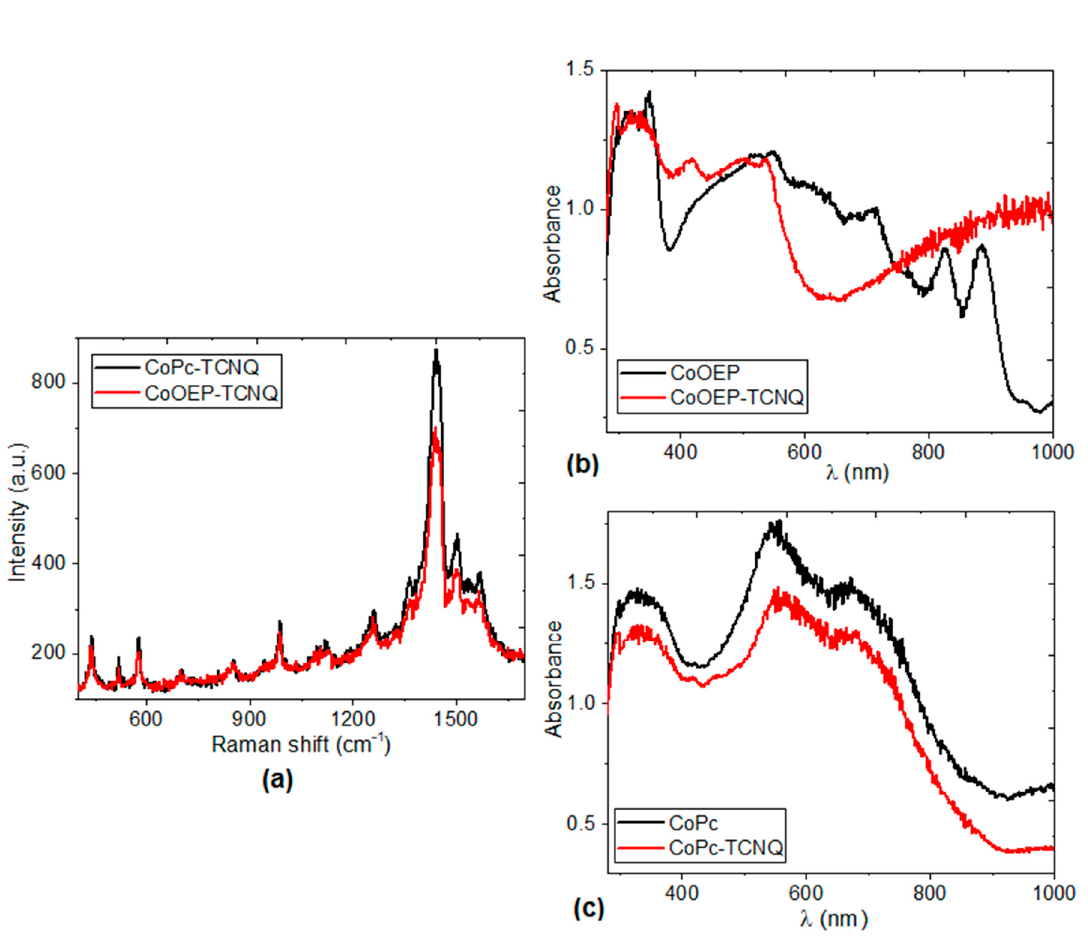
Figure 7. ( a ) Raman spectra of the CoPc-TCNQ and CoOEP-TCNQ thin films; UV-vis spectra of the ( b ) CoOEP-TCNQ and ( c ) CoPc-TCNQ films and their corresponding precursors CoOEP and